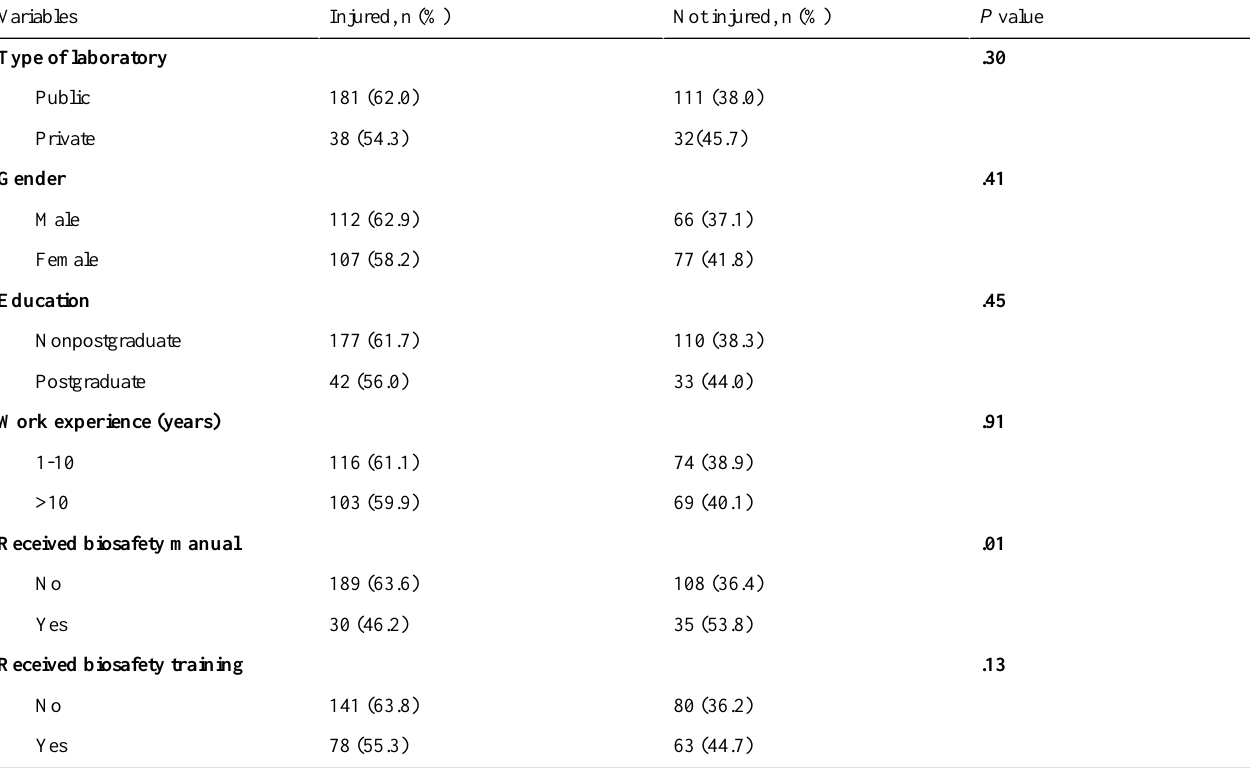
Table 2. History of injury among laboratory staff during their work, and associated factors